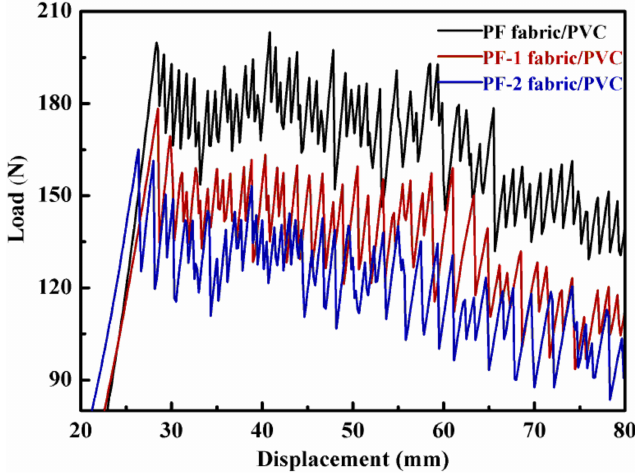
Figure 15. Typical tearing curves of PET fabric/PVC